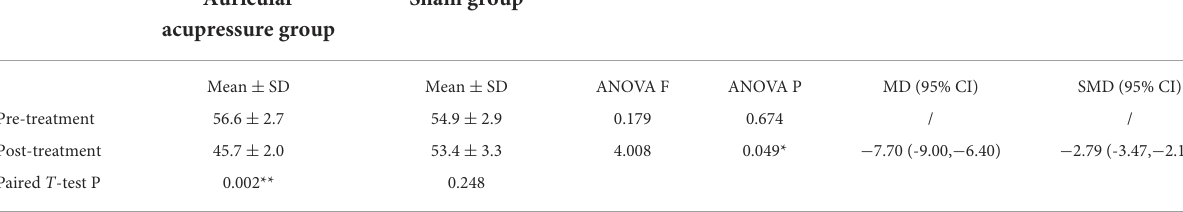
TABLE 2 Results of SDS in auricular acupressure and sham groups. Auricular